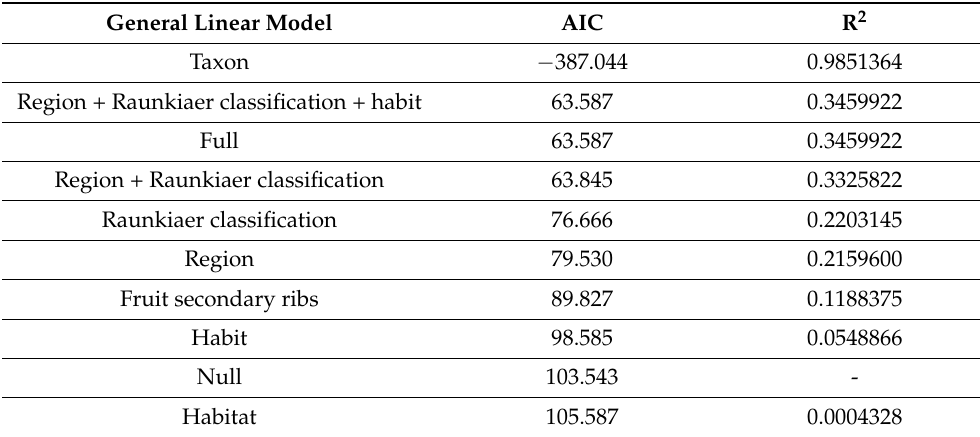
models were ranked by their Akaike’s information criteria (AIC) and adjusted R 2